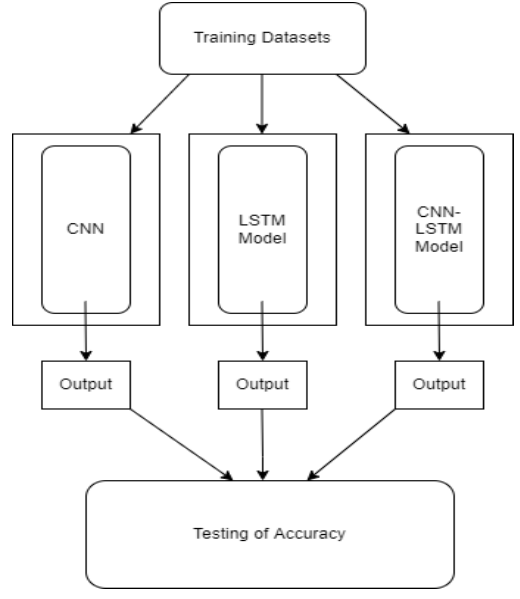
Figure 4. Comparison of CNN, LSTM, CNN- LSTM